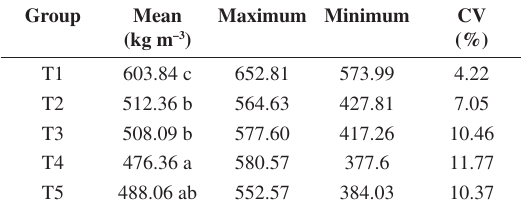
Table 2. Statistical summary of the variation in basic density of Araucaria angultifolia wood attacked by xylophagous organisms classified according to attack level.